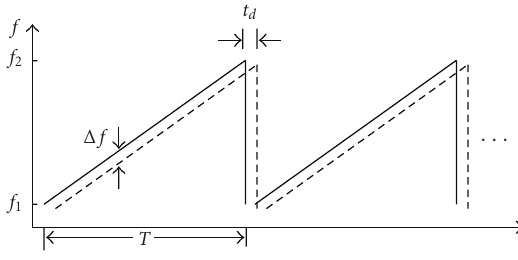
Figure 1: Sketch of transmit and receive signal of FMCW.